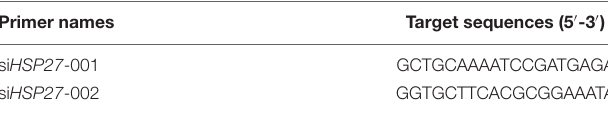
TABLE 1 | Nucleotide sequences of small interfering RNA